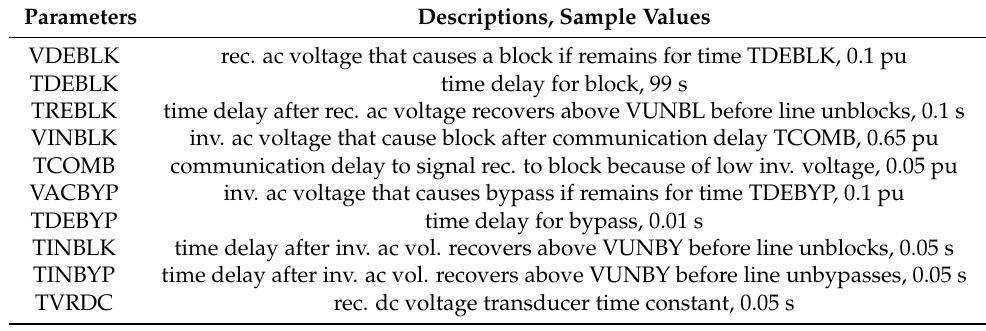
Table 2. Additional parameters for CDC6T model.